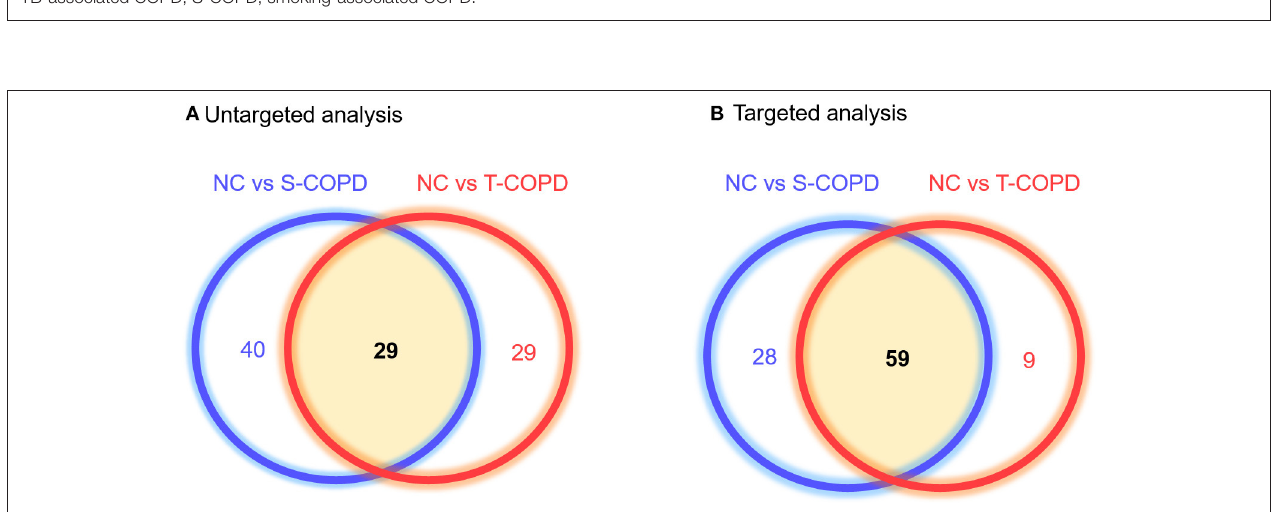
FIGURE 2 | Venn diagram of metabolites identified in patients with T-COPD and S-COPD. (A) Comparison of the NC and S-COPD groups revealed that 8,183 ions and 69 metabolites were significantly altered. In the comparison of the NC and T-COPD groups, 5,193 ions were detected, and 58 metabolites were significantly different. Twenty-nine metabolites were shared by the two COPD groups. (B) Using the targeted analysis, 188 metabolites were quantified, 87 metabolites were significantly altered between the NC and S-COPD groups, and 68 metabolites were significantly altered between the NC and T-COPD groups. Fifty-nine metabolites overlapped in these two comparisons and their direction of regulation was also similar in the S-COPD and T-COPD groups, compared to the NC group. The blue circle indicates metabolic biomarkers obtained from the comparison of the NC and S-COPD groups, and the red circle represents metabolic biomarkers identified in the comparison of the NC and T-COPD groups. NC, normal control; T-COPD, TB-associated COPD; S-COPD, smoking-associated